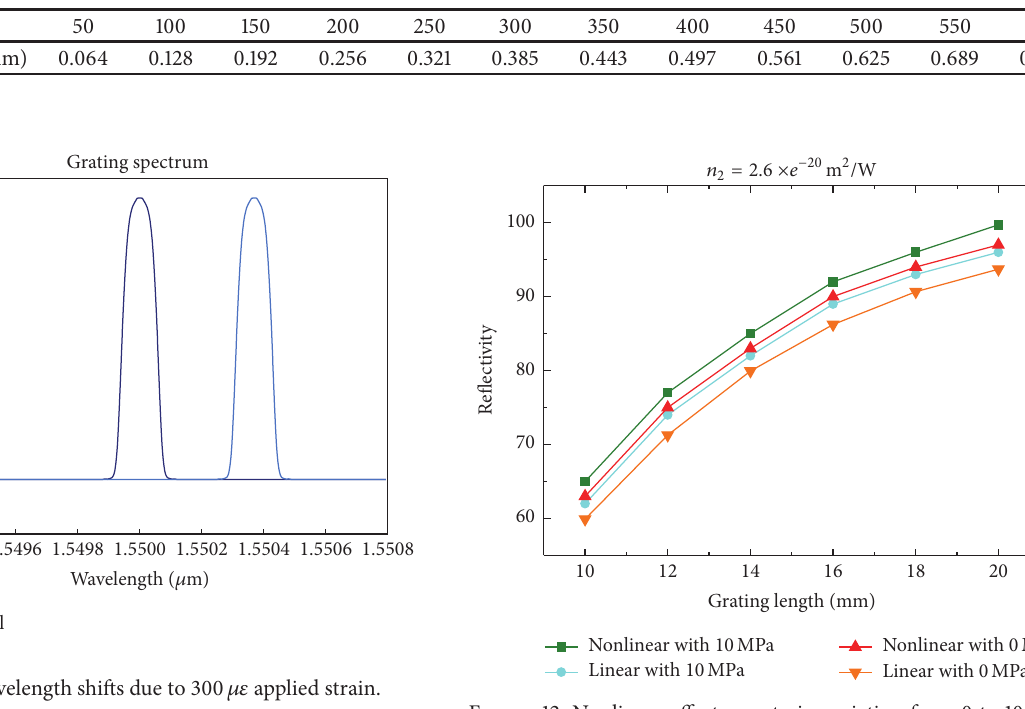
Figure 12: Nonlinear effects on strain variation from 0 to 10MPa with 𝑛 2 = 2.6 × 10 −20 m 2 /W.